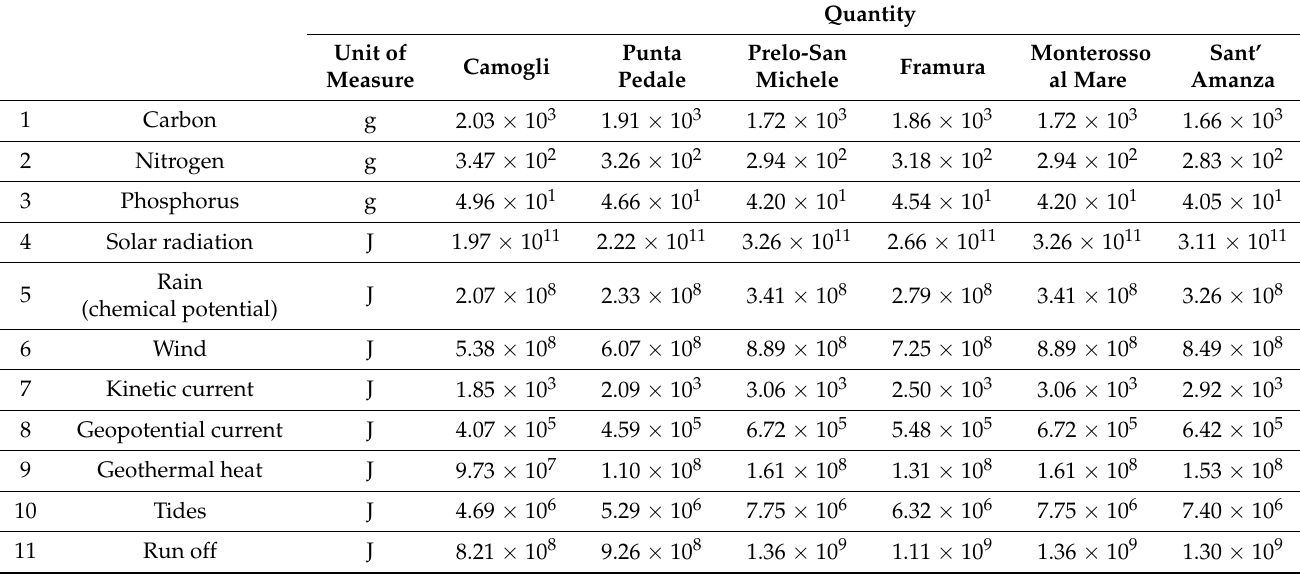
results obtained for each resource (Table 4) were then converted into emergy units by using specific UEVs reported in Appendix C (Table 5). Table 4. Quantity of natural resources necessary to sustain primary production of the meadows analysed.